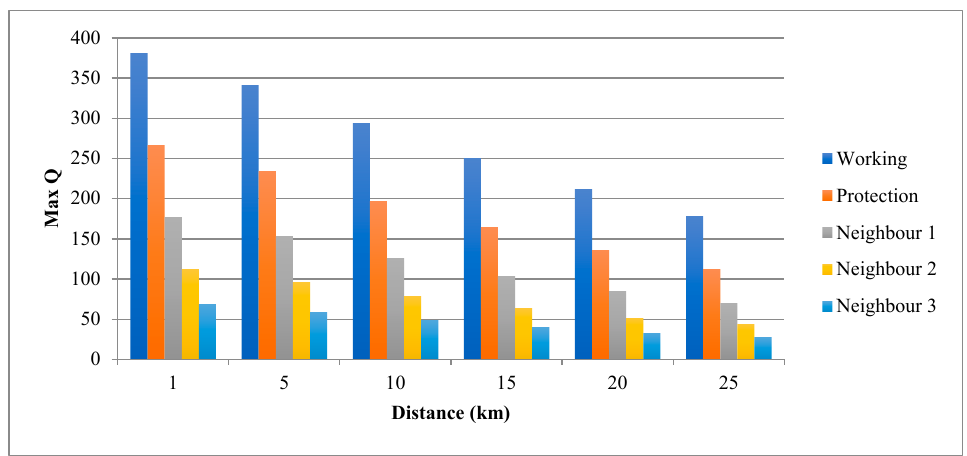
Figure 24. Max Q factor recorded with the ‘zig-zag’ configuration by varying the feeder distance.